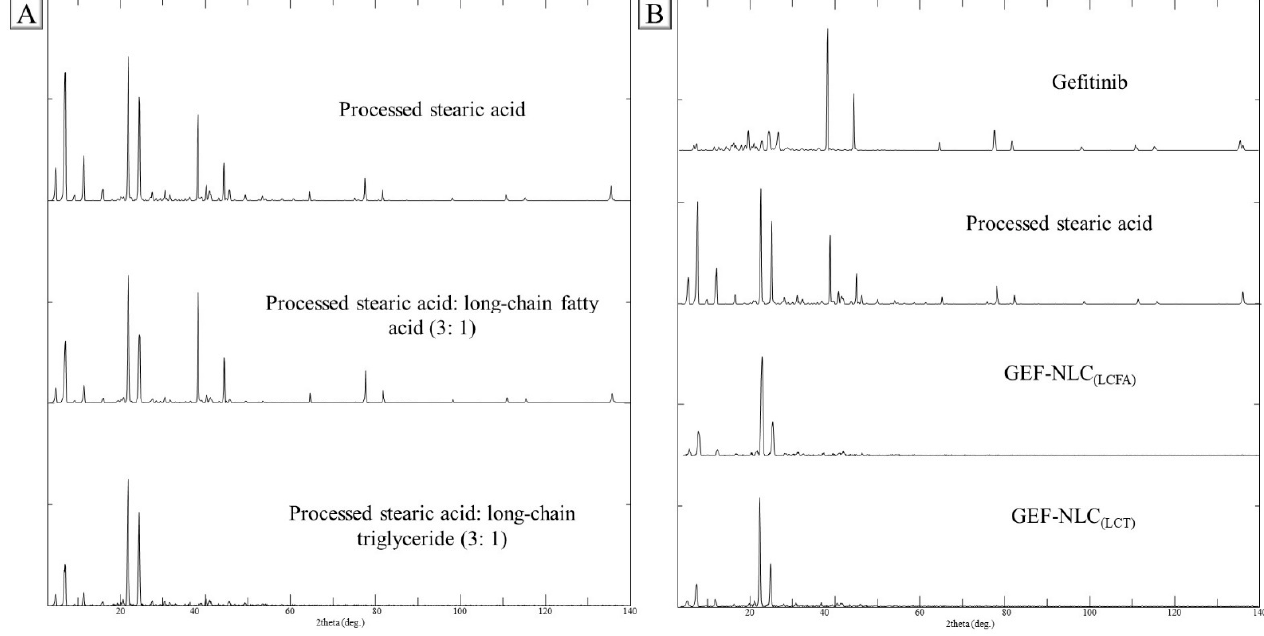
Figure 7. PXRD of ( A ) processed SA, processed SA:LCFA (3:1), and processed SA:LCT (3:1), ( B ) GEF, processed SA, GEF-NLC (LCFA) , and GEF-NLC (LCT) .